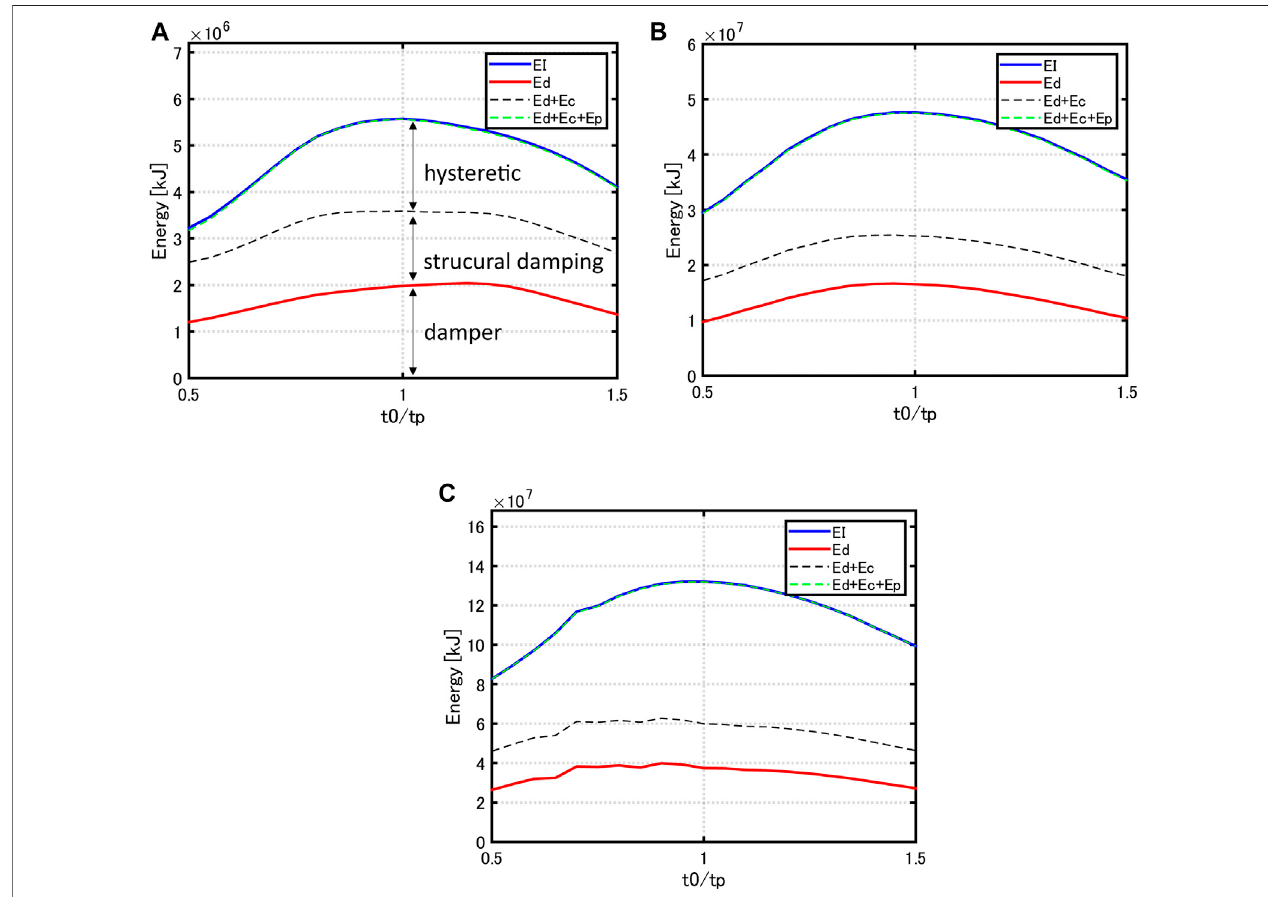
FIGURE 7 | Input energy with respect to interval of double impulses ( Δ t (cid:1) 0 . 001 [ s ] ), (A) V DI (cid:1) 0 . 20 [ m / s ] , (B) V DI (cid:1) 0 . 60 [ m / s ] , (C) . V DI (cid:1) 1 . 00 [ m / s ] .